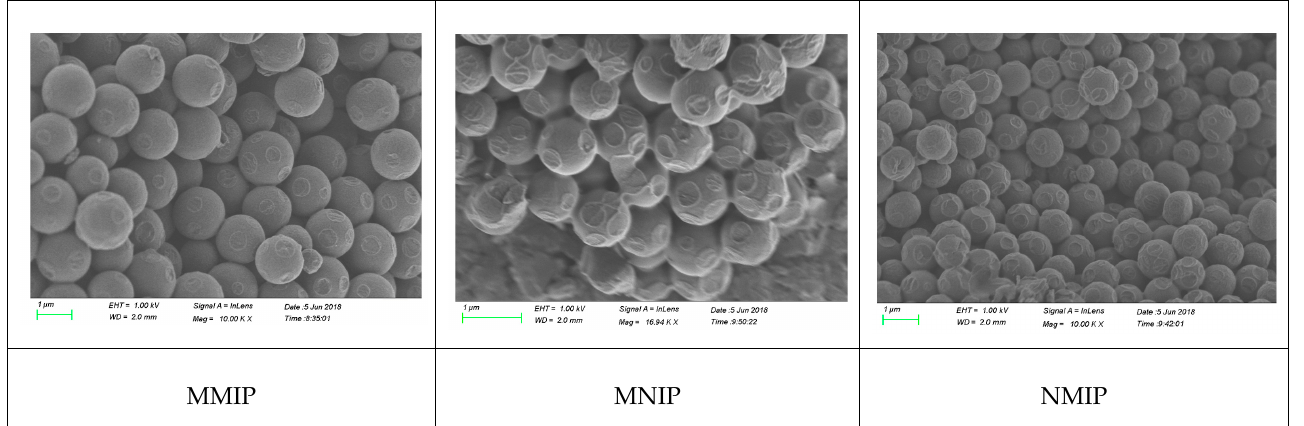
Figure 2. The SEM spectrum of MIP.